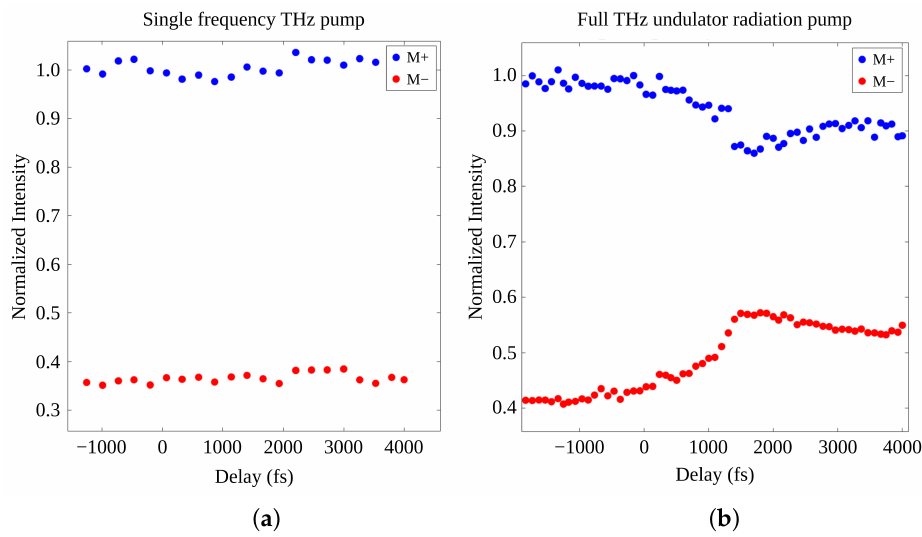
Figure 4. Normalized T-MOKE intensity for two opposite magnetization directions ( a ) for a single frequency THz pump (3THz) and ( b ) for a pump consisting of the complete radiation content deliv- ered by the THz undulator (fundamental frequency of 6.7THz). In the first case, the magnetization does not change while in the latter case the pump triggers a modification of the magnetization on a timescale of a few